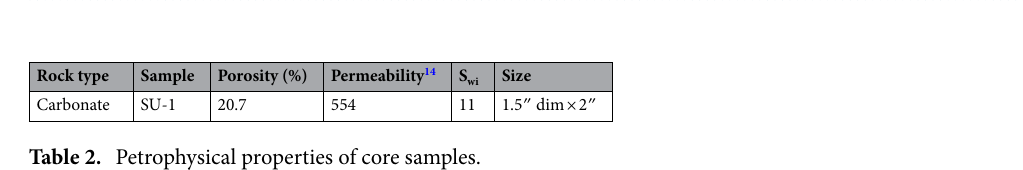
Table 2. Petrophysical properties of core samples.